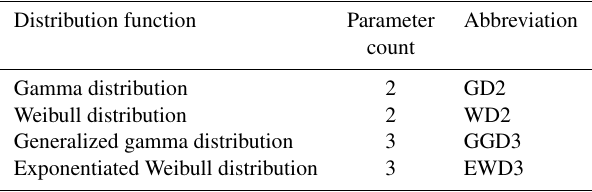
Table 1. Abbreviations used for candidate distribution